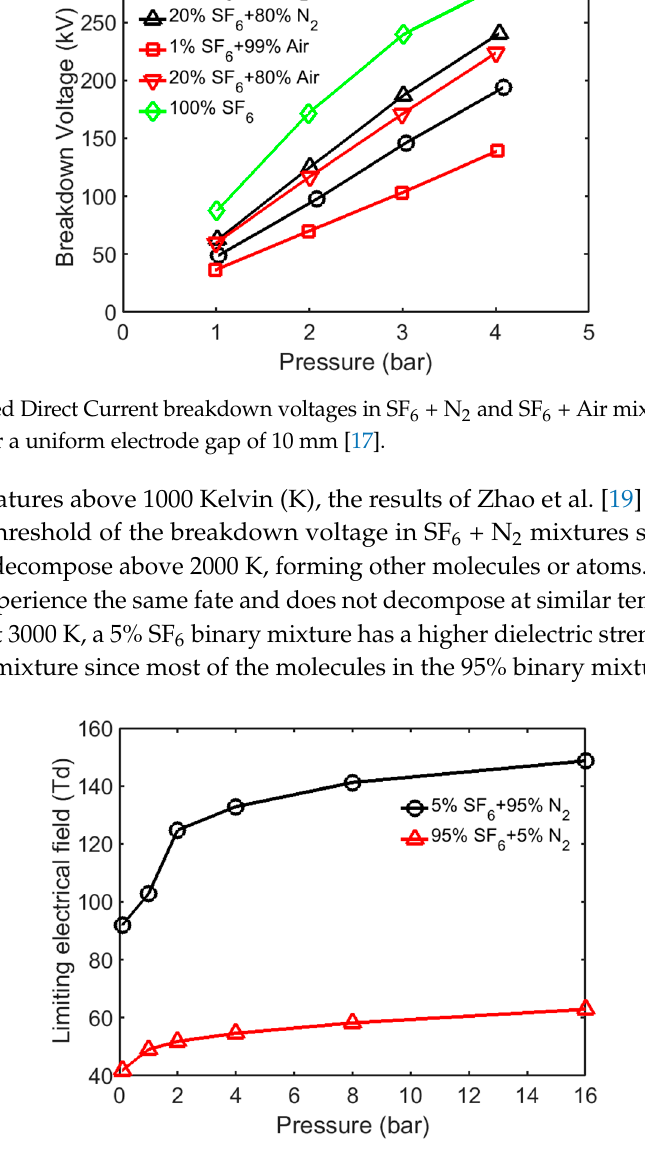
Figure 3. Limit electrical field in SF 6 + N 2 at 3000 K [19].